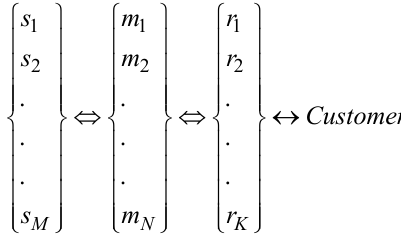
Fig. 1. The three-echelon supply